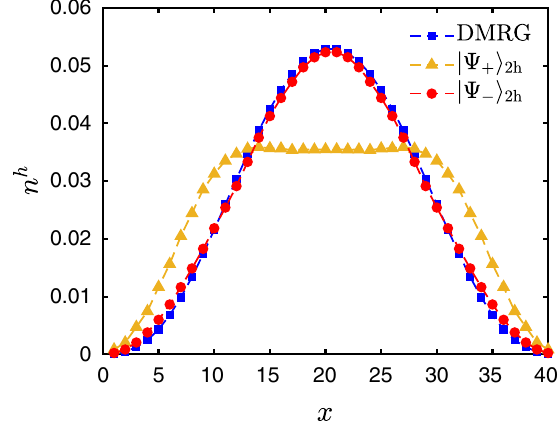
FIG. 6. The density distribution of two holes in a 40 × 2 ladder obtained by VMC and DMRG methods.